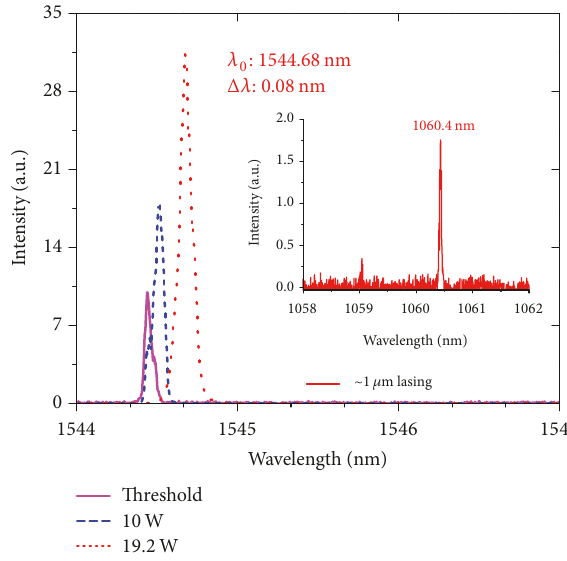
Figure 4: Laser output spectrum from standard single-mode fiber end and spectrum of the leaked laser from the high-reflection FBG1 end in comparison. Inset: measured spectrum of ∼ 1 𝜇 m parasitic